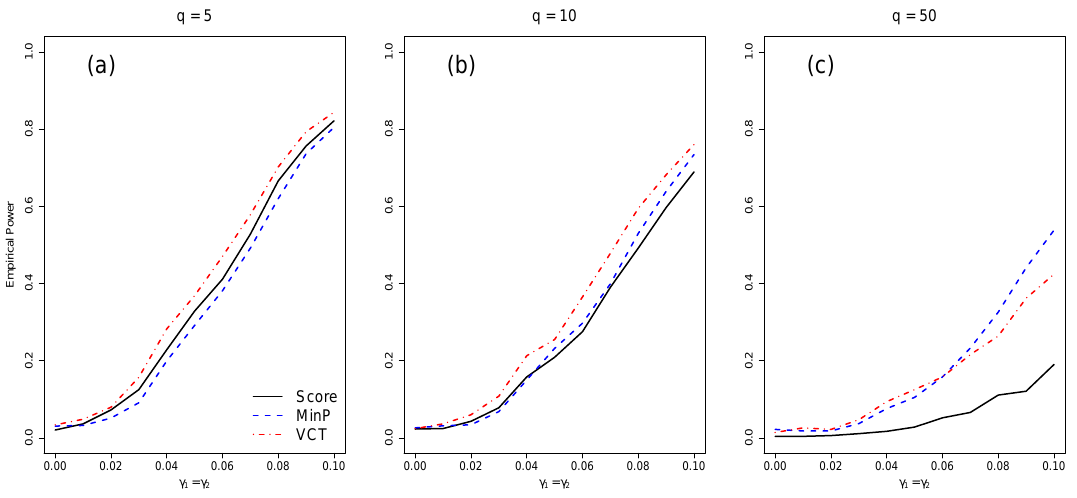
Figure 3. Empirical power at 0.05 α -level of the methods for q independent SNPs of which two of the SNPs have a main effect. The same two SNPs have an equal interaction with the environment. ( a ) q = 5 independent SNPs; ( b ) q = 10 independent SNPs; ( c ) q = 50 independent SNPs.